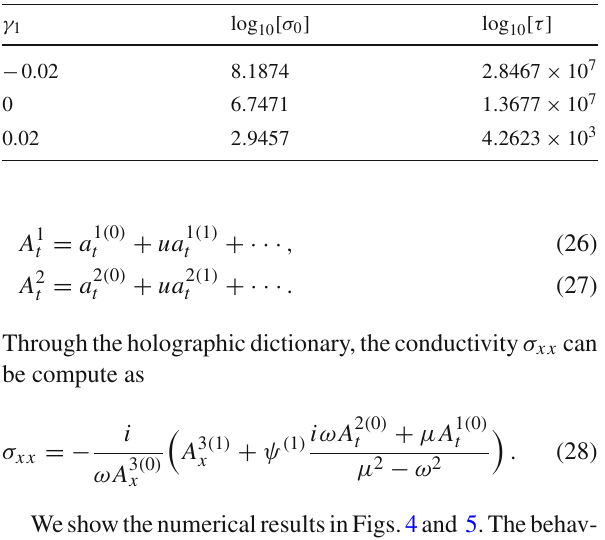
Table 10 The values of log 10 [ σ 0 ] and log 10 [ τ ] from the fitting points in 6 derivative theory with different γ . Here γ =